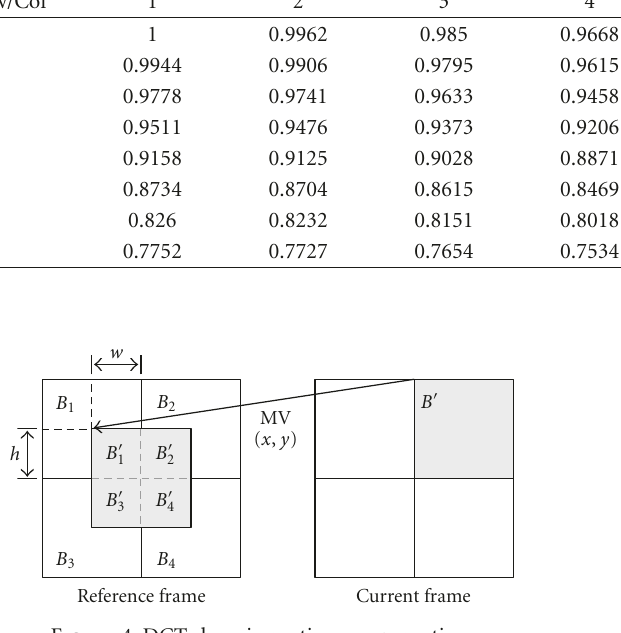
Figure 4: DCT-domain motion compensation.